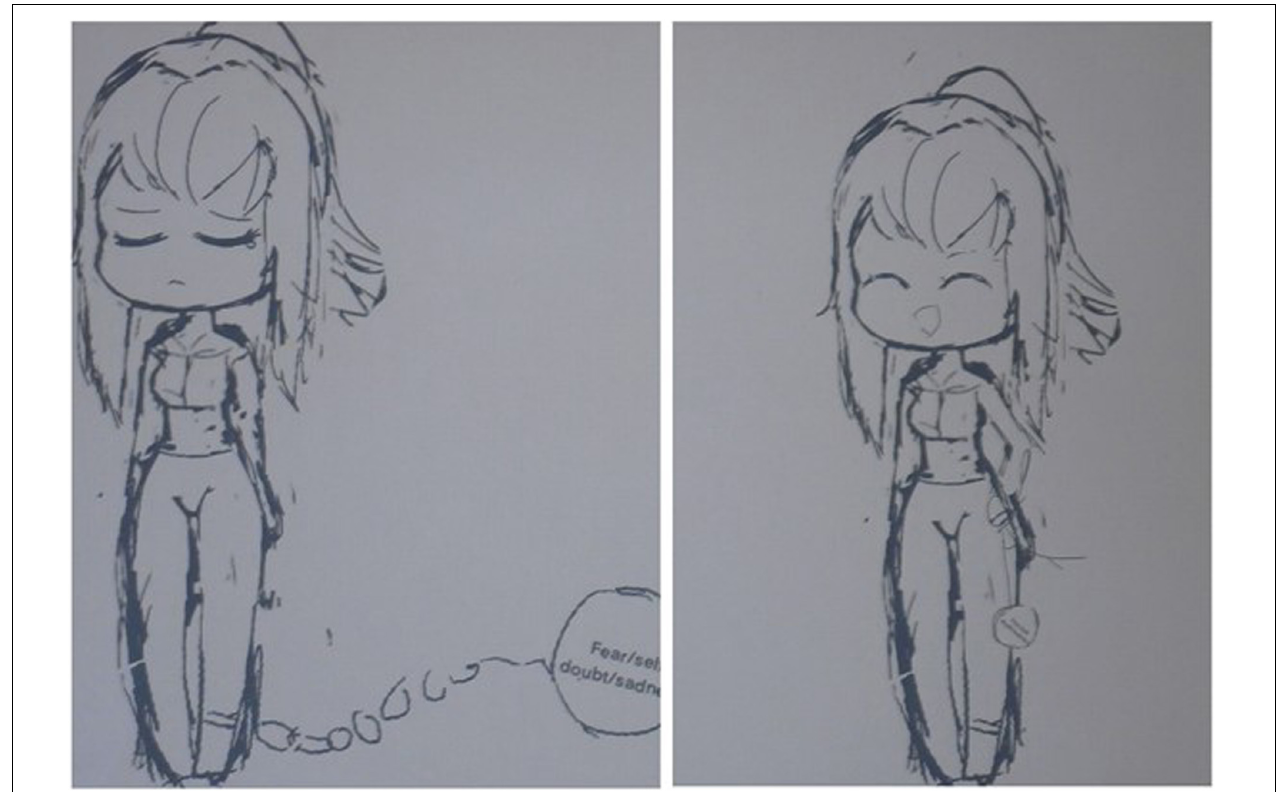
FIGURE 5 | The drawing of the “intangible feeling of fear” symbolized in a heavy ball on the chain on her leg and the drawing in which she transformed it into a tennis ball.